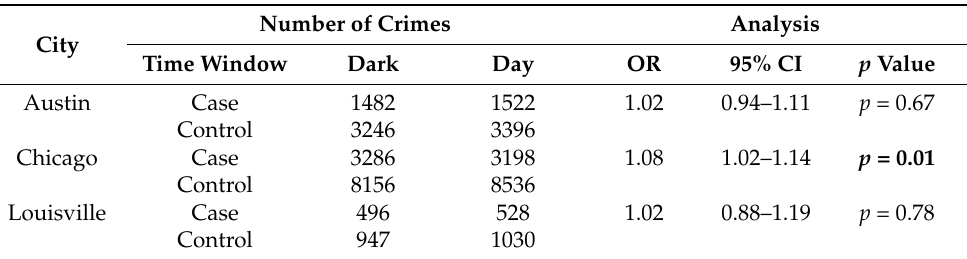
Table 4. ORs and 95% CIs associated with the change in crime frequency at dark compared to daylight for the three separate cities. The associated p -values indicate whether the OR is significantly different to 1.0 (significant differences noted in bold font).